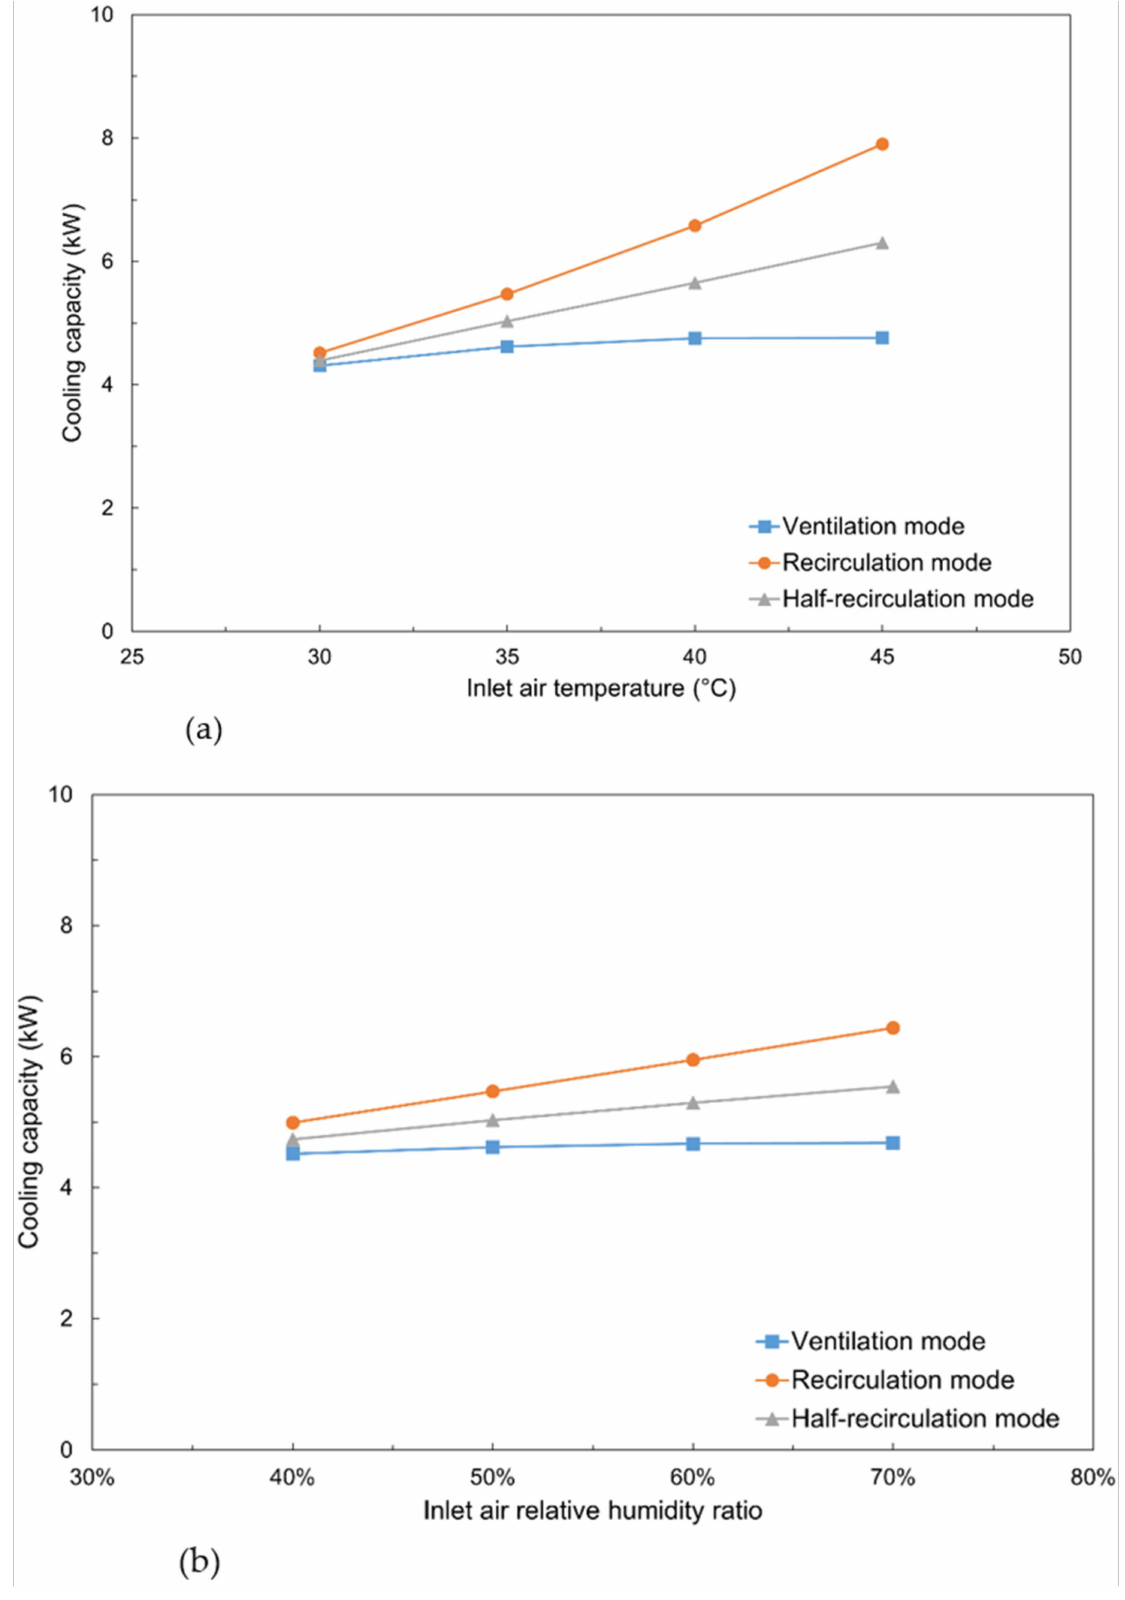
Figure 7. Effects of ambient air ( a ) temperature and ( b ) humidity on cooling